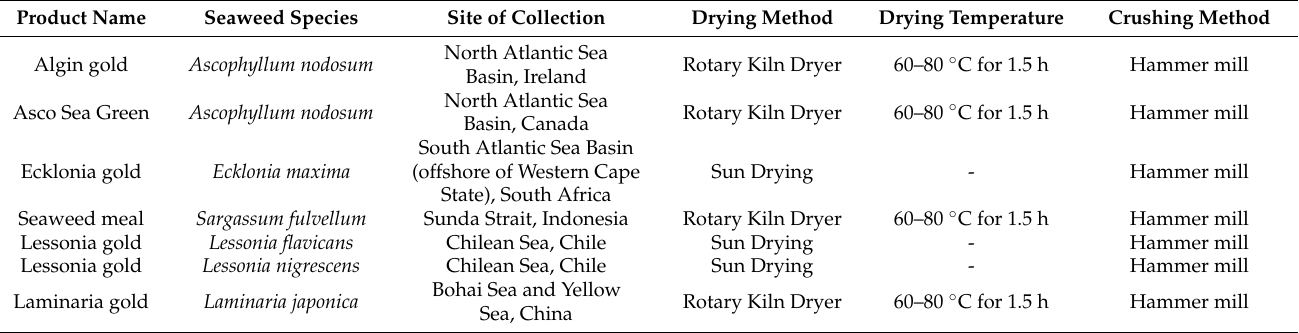
Table 2. Site of harvesting and processing of the evaluated commercial brown seaweed